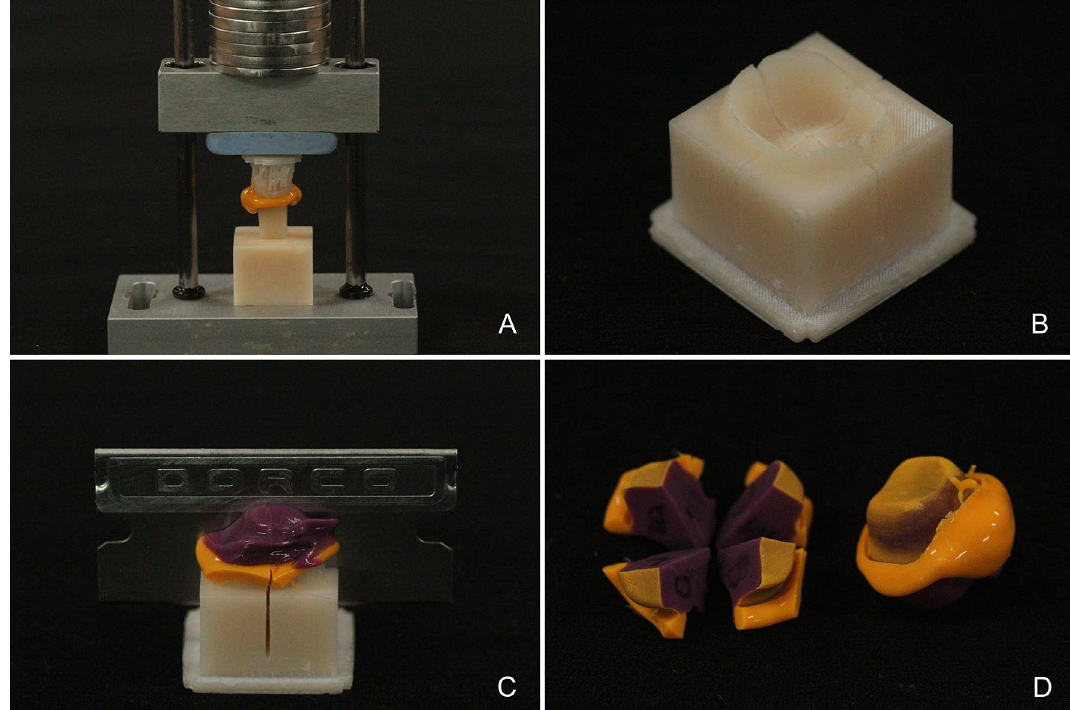
Figure 2. Procedure for the marginal and internal fit using the silicone replica technique. ( a ) Applying constant load for the interim crown with silicone, ( b ) guide template for cutting of the silicone replica, ( c ) cutting of the silicone replica, ( d ) silicone replica.